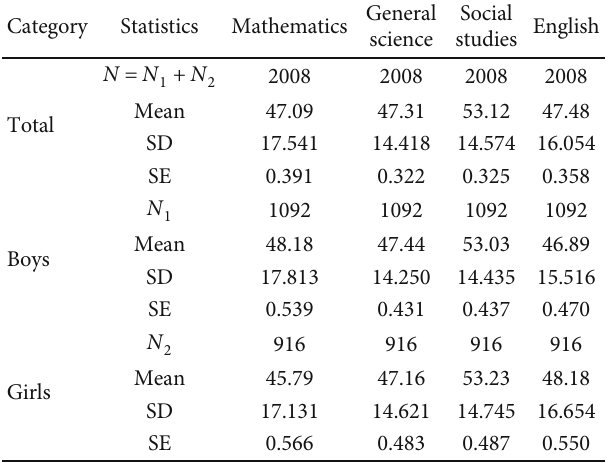
Table 4: The descriptive statistics for total boy and girl students.